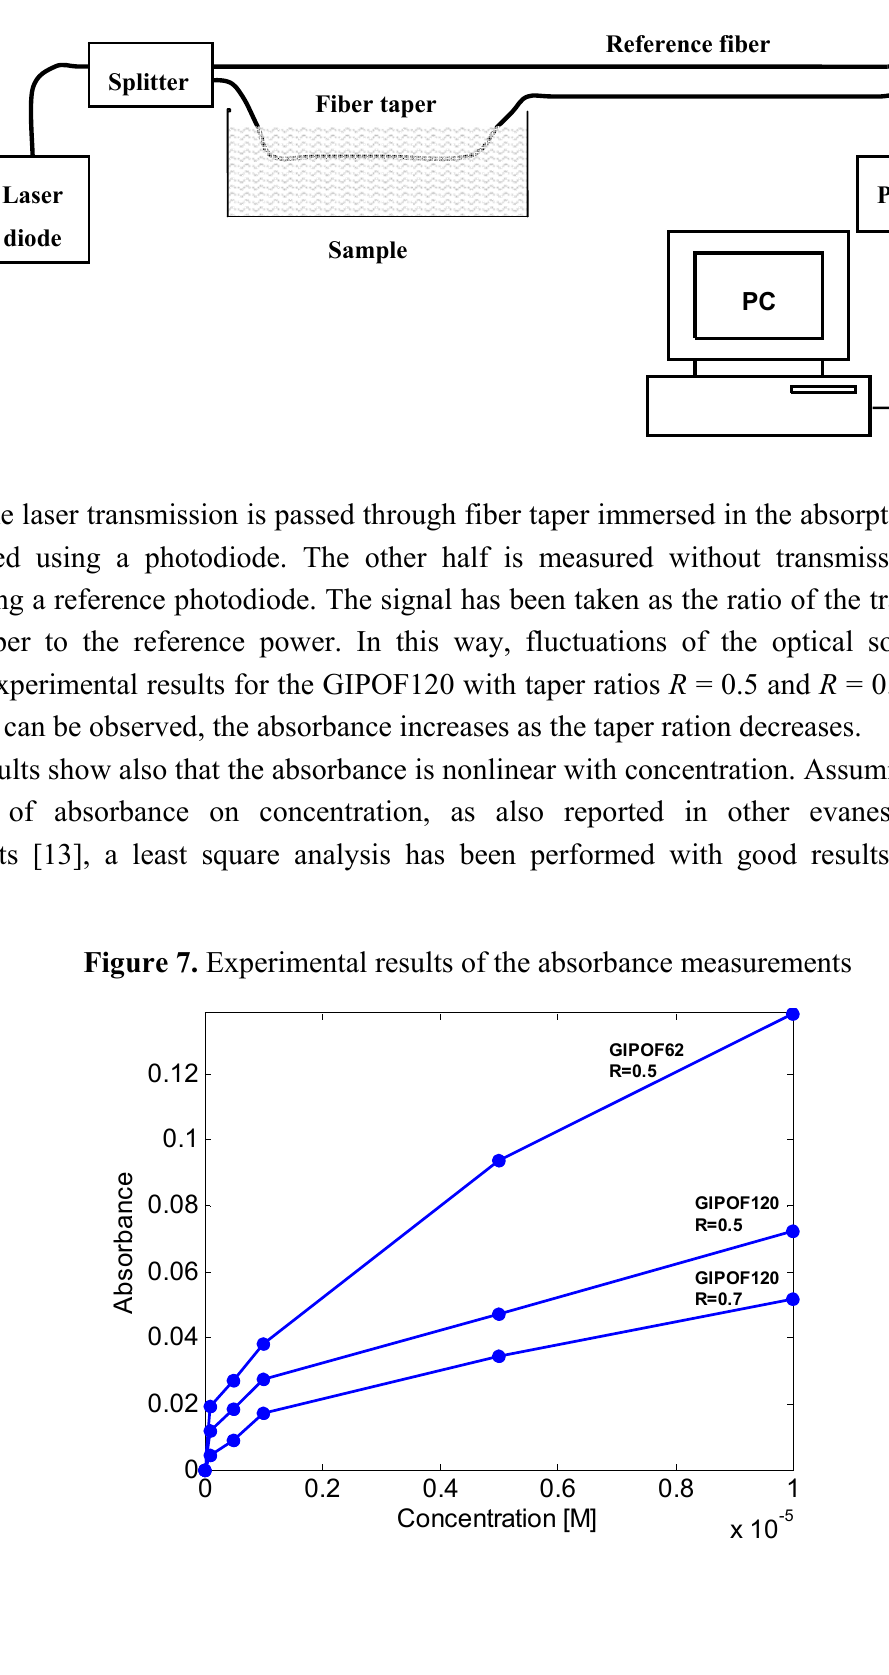
Figure 6. Experimental setup for evanescent wave absorption measurements.